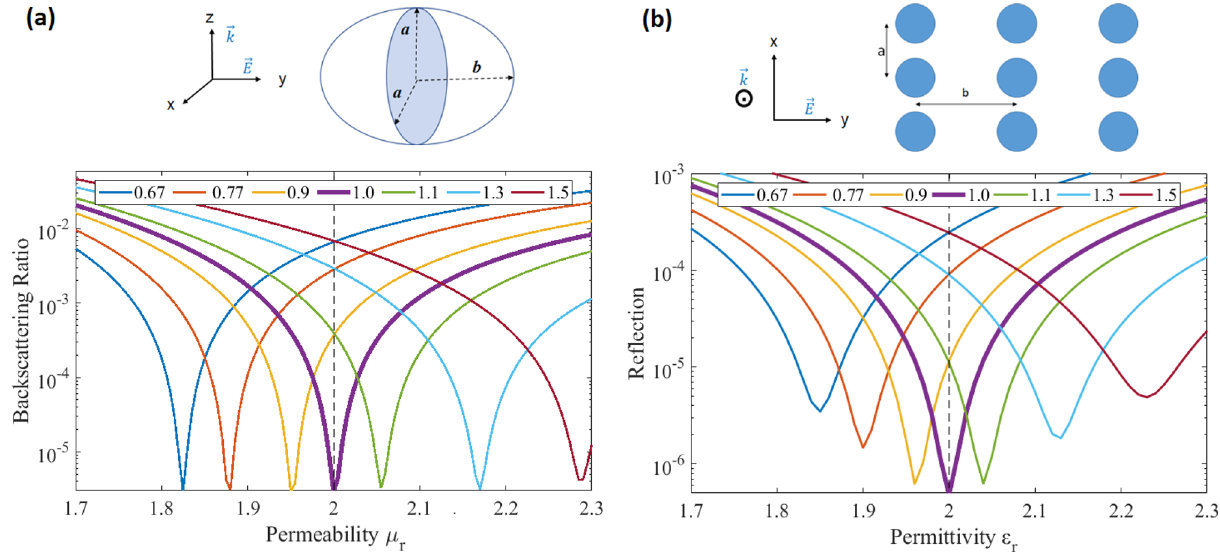
2 for a varying axial ratio b / a (legend) = 2 = 1 . =